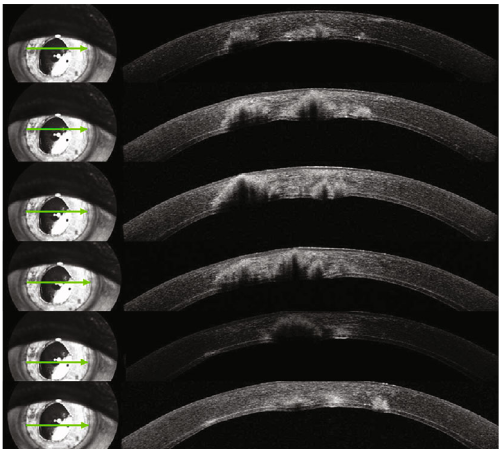
Figure 2: Anterior segment optical coherence tomography images of the patient at presentation. Graft-host interface and the stromal in fi ltrate with a shadow in the corneal stroma underlying the fungal lesion.